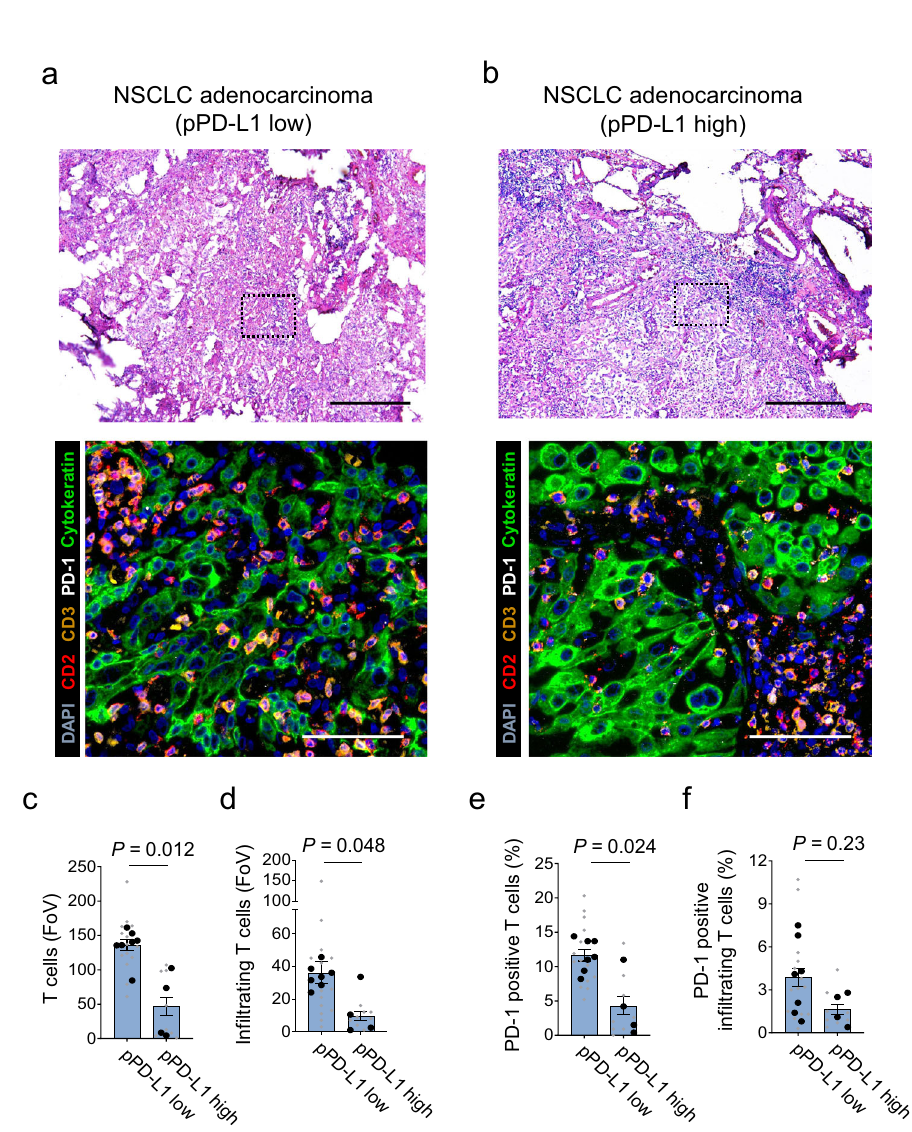
Fig. 4 PD-L1 on platelets shows functional relevance via decreasing T-cell activity. a IFN γ ELISPOT assay of peptide-speci fi c T-cells co-incubated with PD- L1 + platelets with or without anti-PD-L1 mAb pre-treatment ( n = 3). b Quanti fi cation of the IFN γ ELISPOT assays ( n = 3). c Flow cytometry-based quanti fi cation of indicated cytokines and surface markers for peptide stimulated CD8 + T-cells co-incubated with PD-L1 + platelets with or without anti-PD-L1 mAb pre-treatment ( n = 3). d Representative FACS plots showing the gating strategy and the T-cell subpopulations after pre-sensitization, enrichment, and expansion. e Quantitative sub-phenotyping of NY-ESO-1 speci fi c T cells using fl ow cytometry ( n = 2). f Representative FACS plots displaying CD4 + TEM activity levels measured by INF γ expression after co-incubation with PD-L1 + platelets with or without anti-PD-L1 mAb pre-treatment ( n = 3). g Quanti fi cation of INF γ + CD4 + TEM ( n = 3). h IFNy fold change in CD4 + TEM ( n = 3). i Representative FACS plots displaying CD4 + TEM activity levels measured by TNF α expression after co-incubation with PD-L1 + platelets with or without anti-PD-L1 mAb pre-treatment ( n = 3). j Quanti fi cation of TNF α + CD4 + TEM ( n = 3). k , TNF α fold change in CD4 + TEM ( n = 3). b , c , g , h , j , k Data are mean±SEM. Statistical signi fi cance was calculated by two-tailed Student ’ s t test. Source data are provided as a Source Data fi le.